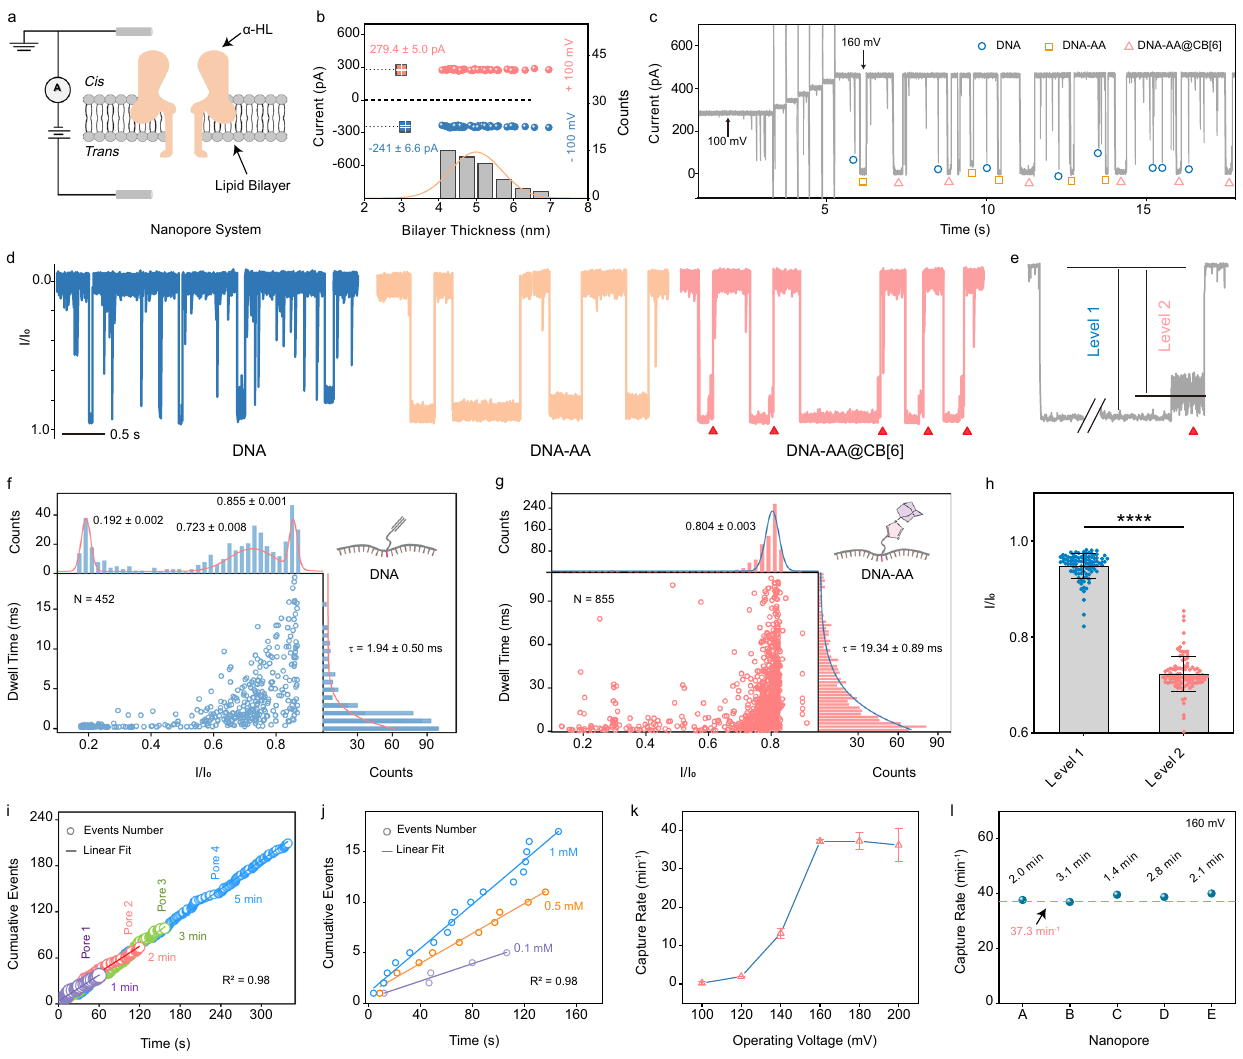
Fig. 2 | Characterization of nanopore and multi-level signature events. a Schematic illustration of an α -HL protein inserted into a lipid bilayer membrane with an applied external voltage. The potential across the bilayer is applied to the trans side through Ag/AgCl electrodes, while the cis side is grounded. b Correspondingaverageopenporecurrentvaluesat±100mVandthedistribution of calculated thicknesses of lipid bilayer membranes ( n =50 biologically indepen- dent experiments). c Continuous raw current traces of DNA probes achieved in different stages of synthesis. Circles, squares, and triangles indicate alkyne mod- i fi ed DNA, DNA-AA, and DNA-AA@CB[6], respectively. d Representative current traces of alkyne modi fi ed DNA, DNA-AA, and DNA-AA@CB[6] translocations, respectively. e Atypicalmulti-levelsignaturesignalgeneratedbytranslocationofa DNA-AA@CB[6] probe. Each signal event is characterized by a pattern with Level 1&2. f , g Two-dimensional scatter plots of f alkyne modi fi ed DNA and g DNA-AA translocation signals, respectively. Top: histograms of I/I 0 with Gaussian fi tting.